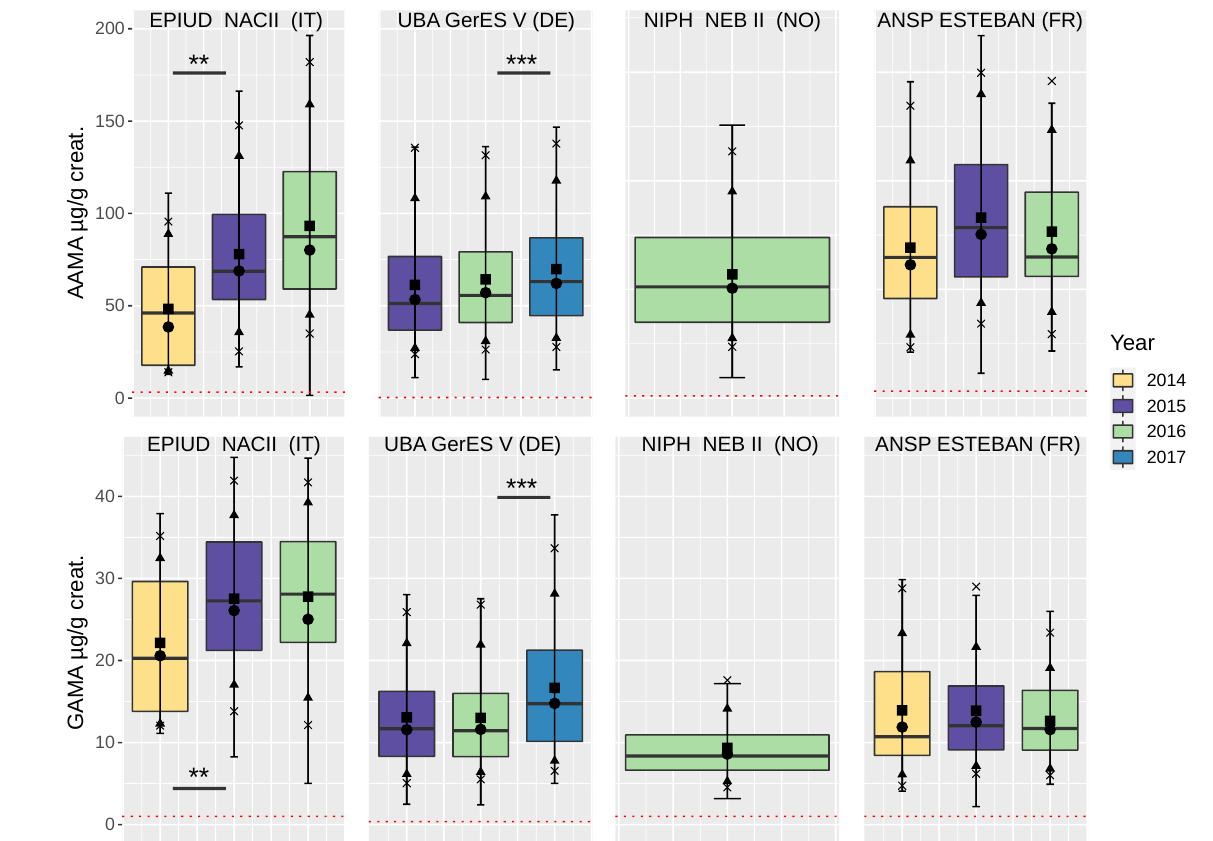
Figure 1. Boxplots of yearly mean (geom. mean, median) AAMA (top) and GAMA (bottom) concentrations in children and teenagers, based on data (non-smoker) of HBM4EU-aligned studies (Italy, NAC II; Germany GerES V; Norway, NEB II; and France, ESTEBAN). Box = 25–75% interquartile range; line = median; (cid:110) = mean; (cid:108) = geometric mean; (cid:115) = 10 + 90% quantile; and x = 5 + 95% quantile. Dotted red line: level of quantification (LOQ). Asterisks indicate significant differences in (ln)AAMA or (ln)GAMA levels (one-way ANOVA), *** p < 0.001, ** p <